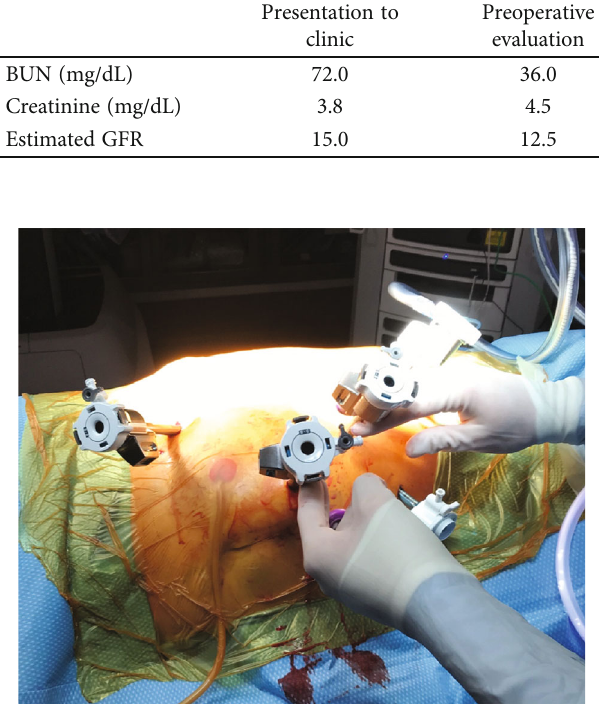
Figure 2: Placement of the